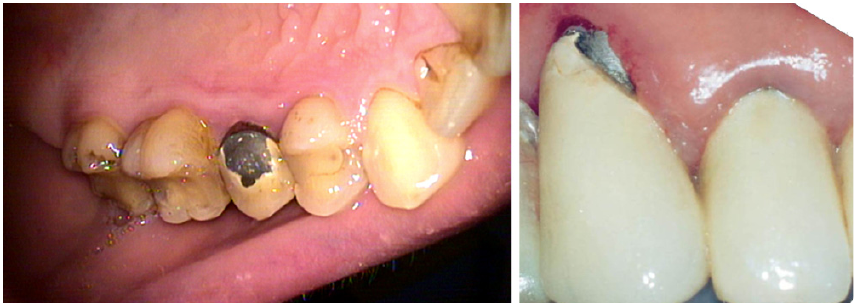
Figure 1. Detachment of veneering ceramics from CoCrMo cast crowns and veneered with dedicated ceramics.